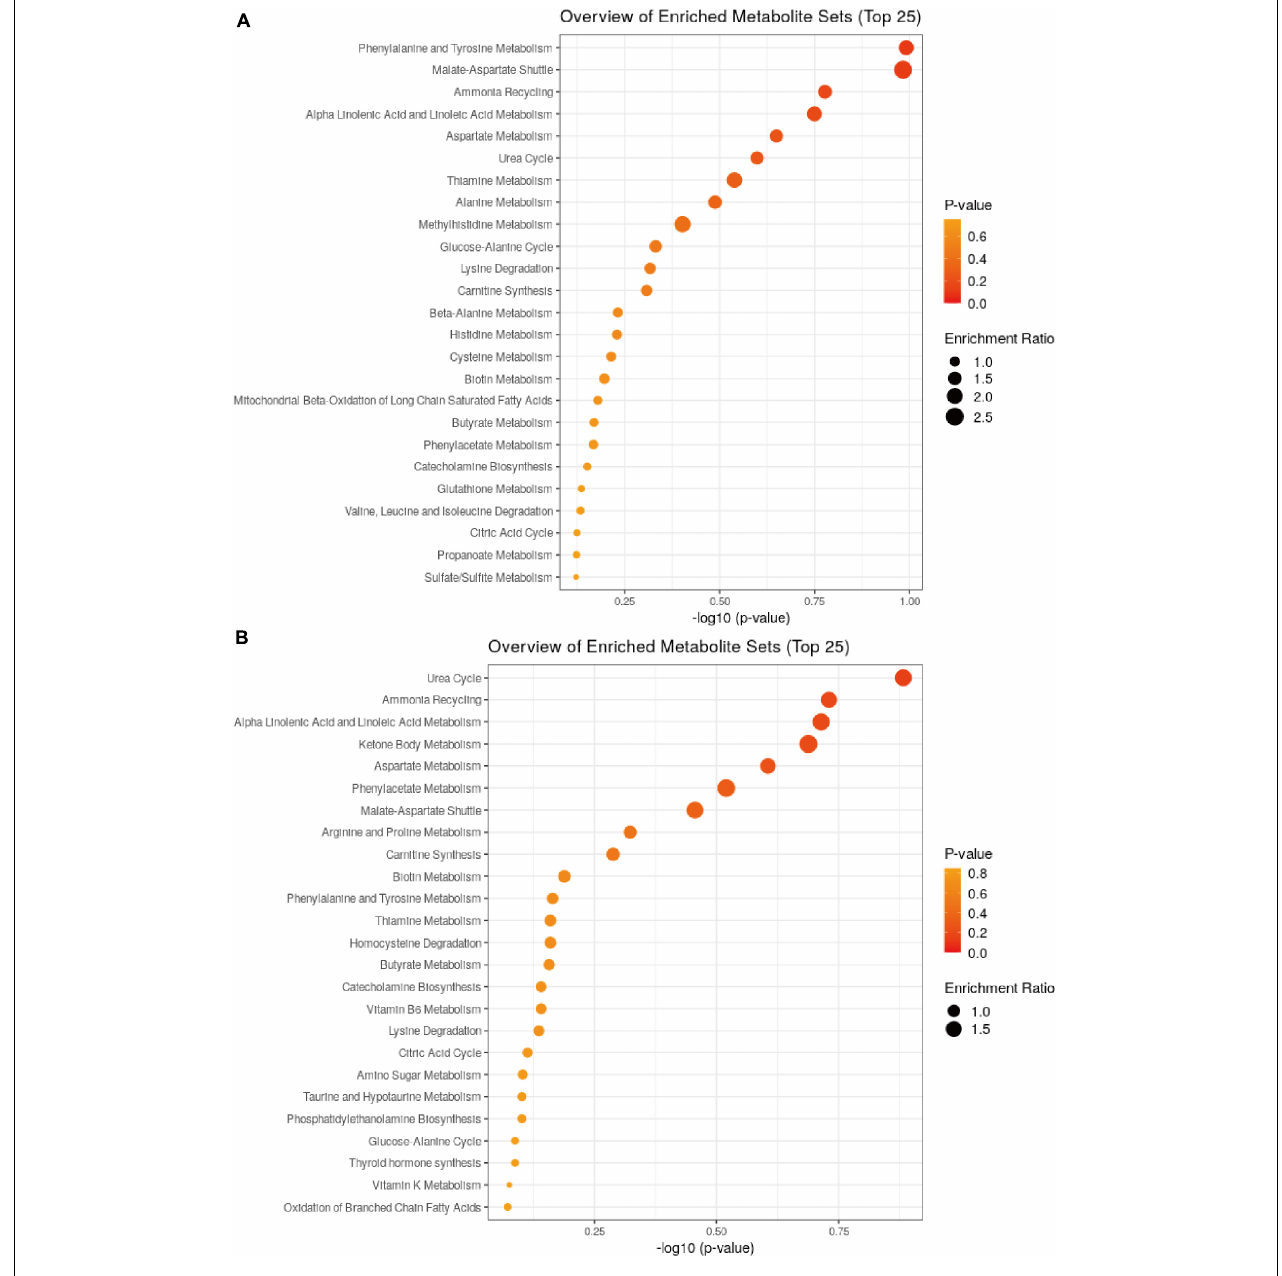
FIGURE 6 | Pathway analysis for metabolites. Summary of pathway analysis for differential metabolites in ggplot2, and significantly enriched pathways are displayed by a bubble plot ( p < 0.05, Fisher’s exact test). ( A : Balb/c-NC vs. Balb/c-5Gy; B : C57BL/6J-NC vs. C57BL/6J-5Gy).